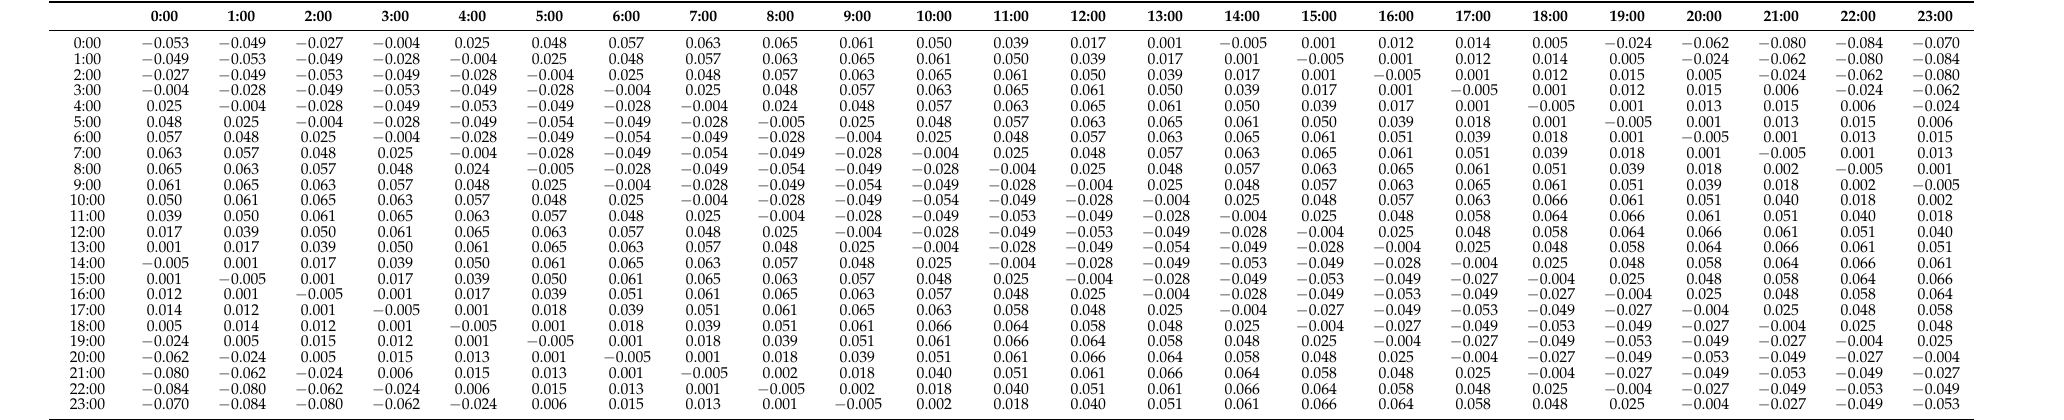
Table A3. Price elasticity coefficient of electricity demand in autumn.